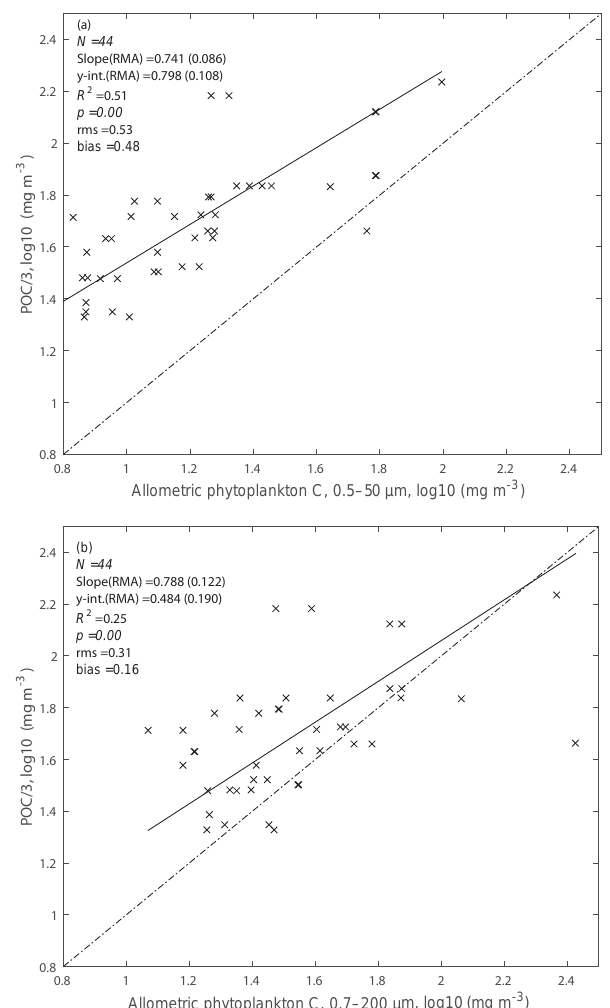
Figure 6. Matchups between phytoplankton carbon estimated by applying allometric relationships to in situ measurements of the PSD ( x axis) and by multiplying in situ chemical POC determi- nations by 1/3 ( y axis). Measurements are coincident in time and space and were conducted on AMT cruises 2, 3 and 4. Two differ- ent limits of integration are used for the allometric estimate: (a) 0.5– 50µm, as in the operational satellite algorithm presented here, and (b) 0.7–200µm, matching the GF / F filter pore size used in POC measurements.